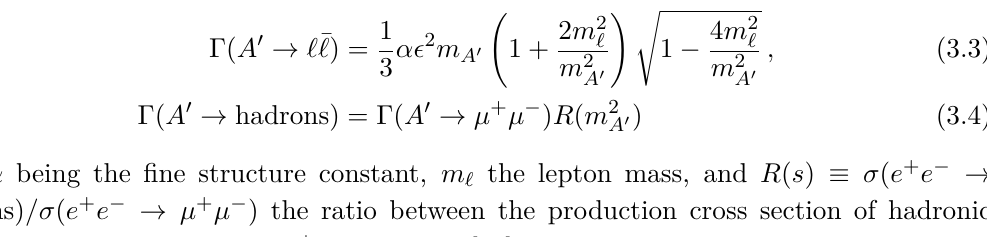
The red (black) curves show the expected 95% C.L. exclusion sensitivity with 1-year (20-year) statistics, based on the respective production mechanism. The solid lines correspond to the limit obtained by the bremsstrahlung productions, while the dotted lines show the limit from the pair- annihilation process. The gray-shaded regions are constrained from past beam dump ex- periments (light gray) [22] and supernova bounds (dark gray) [23]. The yellow-shaded one is the expected sensitivity of SHiP experiment